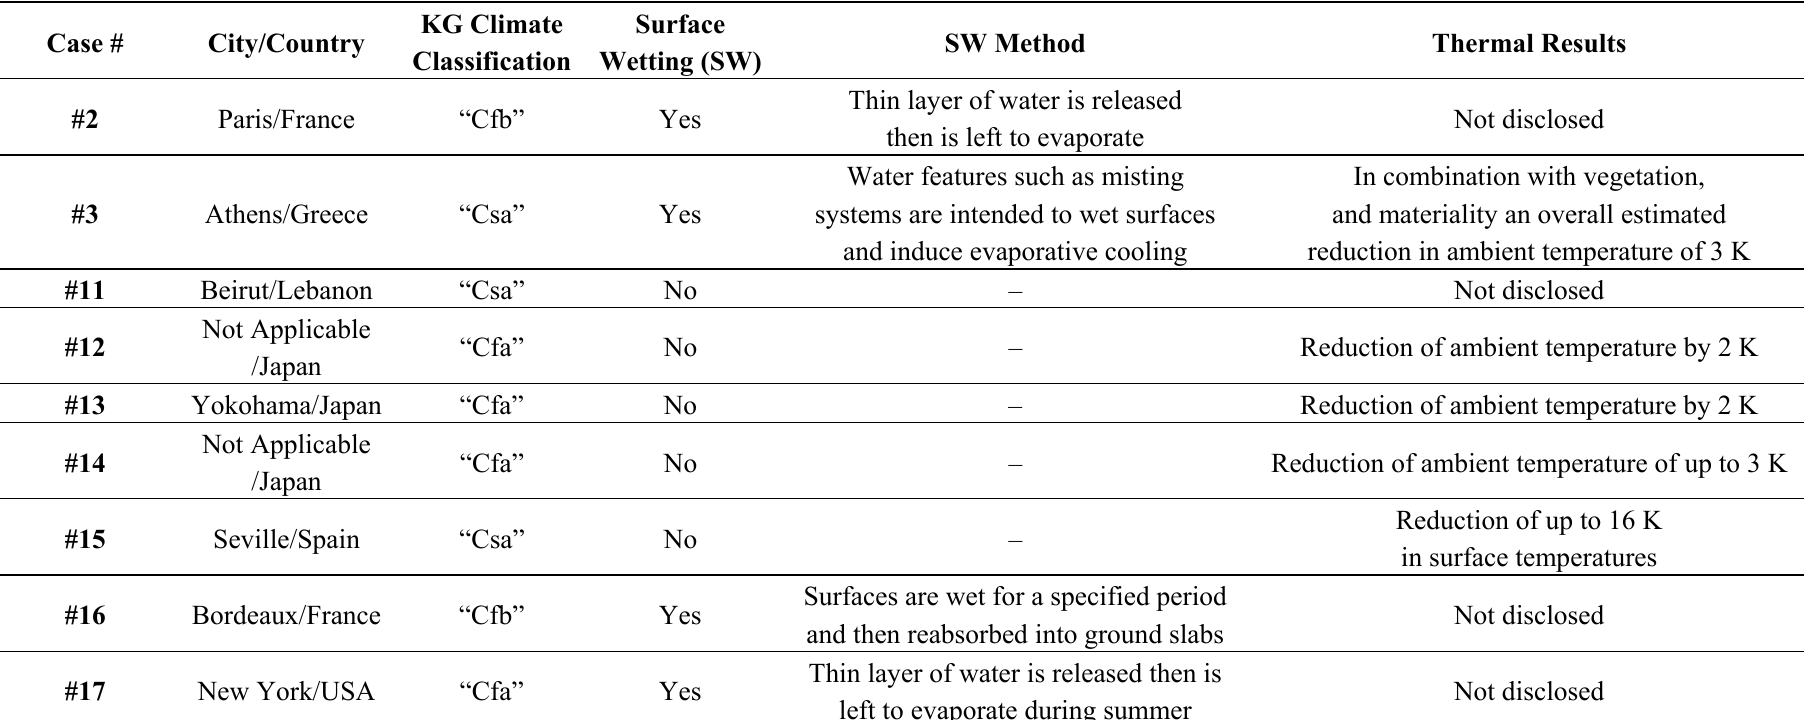
Table 3. Bioclimatic projects and studies that use evaporative